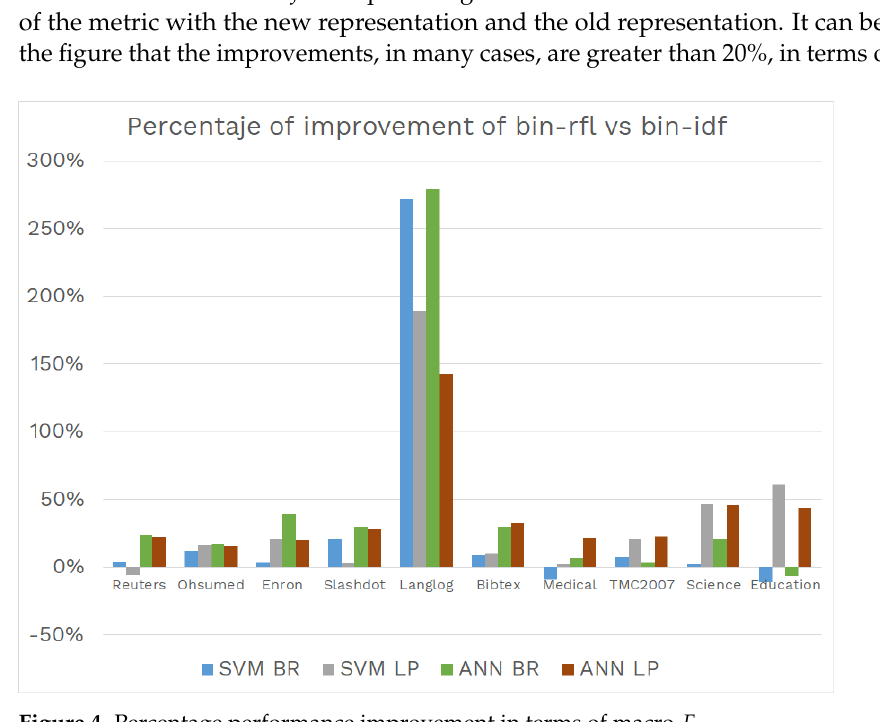
Figure 4. Percentage performance improvement in terms of macro- F 1